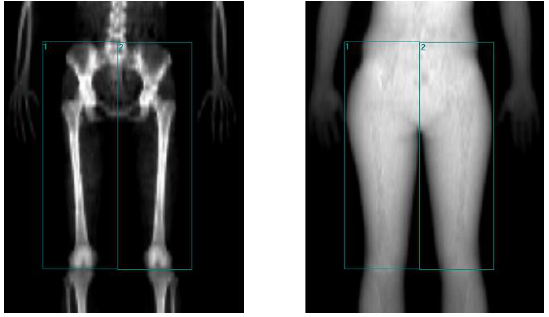
Figure 2. Schematic of the different ROIs used to estimate thigh lean mass by DXA.